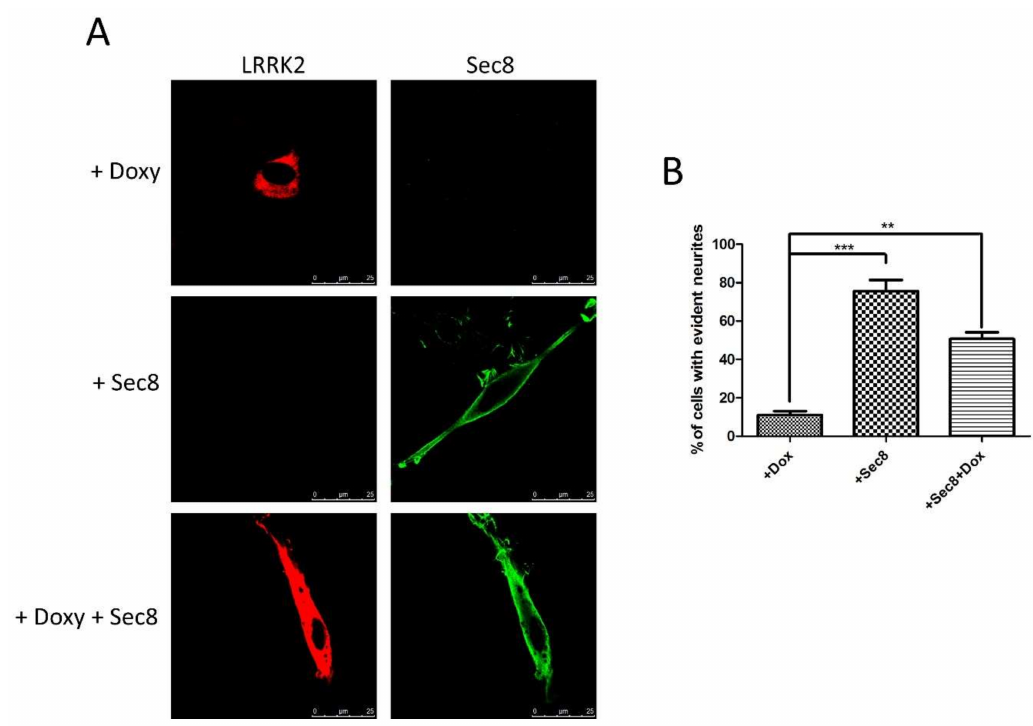
Figure 4. Analysis of Sec8 over-expression on neurite branching in PC12 or SH-SY5Y cells expressing LRRK2 G2019S. ( A ) PC12 cells stably expressing dox-inducible LRRK2 G2019S were transfected by Flag-Sec8 for 48 h and then treated for 6 days by NGF in the presence or absence of dox. ( B ) Quantification of data obtained in ( A ). The data represent the numbers of cells showing evident elongated cytoplasm in three independent experiments and are represented as mean ± SEM. At least 20 cells have been analyzed for each biological replicate. ** p < 0.01; *** p < 0.001. One-way ANOVA and Bonferroni post-test were